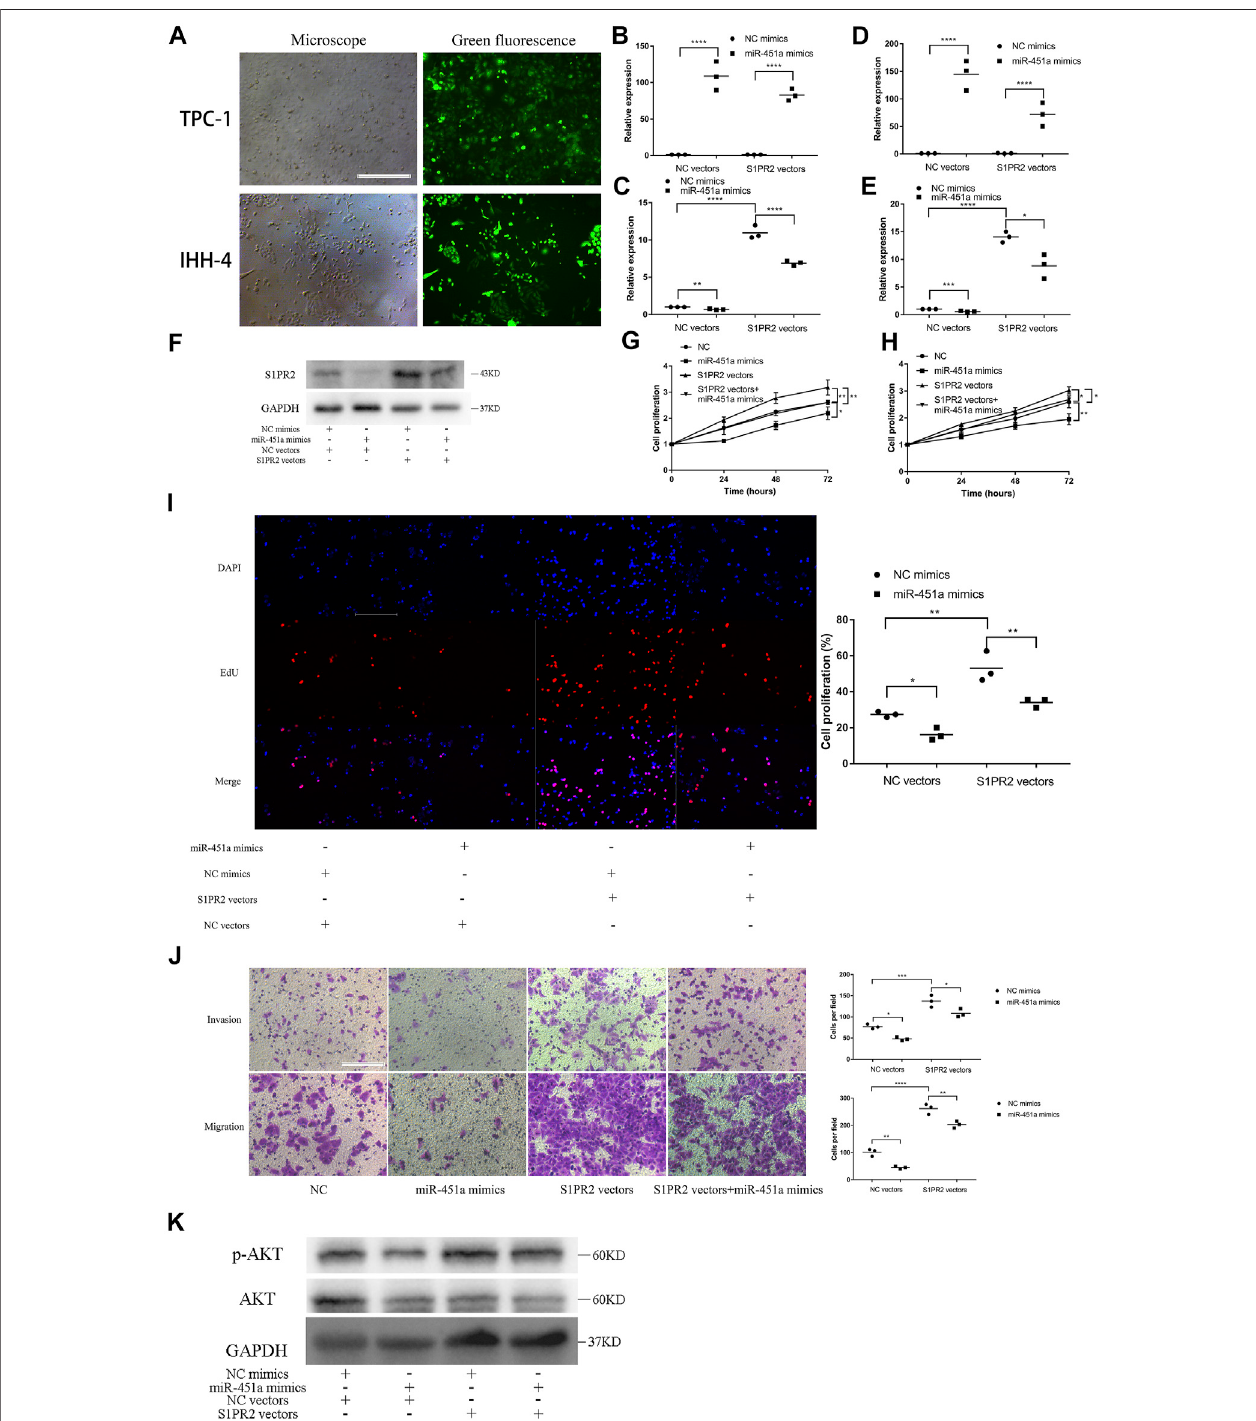
FIGURE 6 | miR-451a inhibited the proliferation, migration, and invasion of PTC cells by targeting S1PR2. (A) Green fl uorescent showing the successful transfectionofS1PR2overexpressionvectorsinTPC-1andIHH-4cells(scalebar=200 um). (B) Theef fi cacyofmiR-451amimicswasrecon fi rmedinTPC-1cellwiththe transfectionofS1PR2vectorsandNCvectors( n =3). (C) TheexpressionofS1PR2inTPC-1cellwiththetransfectionofS1PR2vectorsmiR-451amimics( n =3). (D) The ef fi cacyofmiR-451amimicswasrecon fi rmedinIHH-4cellwiththetransfectionofS1PR2vectorsandNCvectors( n =3). (E) TheexpressionofS1PR2inIHH-4cell withthetransfectionofS1PR2vectorsmiR-451amimics( n =3). (F) TheexpressionofS1PR2proteinintransfectedTPC-1cellbywesternblotassay. (G) CCK8assayto assessthein fl uenceofmiR-451aandS1PR2onTPC-1cell( n =3). (H) CCK8assaytoassessthein fl uenceofmiR-451aandS1PR2onIHH-4cell( n =3). (I) EdUassayof the cell proliferation ability in TPC-1 cell transfected with miR-451a mimics and S1PR2 vectors (scale bar = 100 um, n = 3). (J) Transwell invasion and migration assay in transfectedTPC-1cell(scalebar=100 um, n =3). (K) TheexpressionofAKT,p-AKTproteinsintransfectedTPC-1cellbywesternblotassay.* p < 0.05;** p < 0.01;*** p < 0.001; **** p < 0.0001.